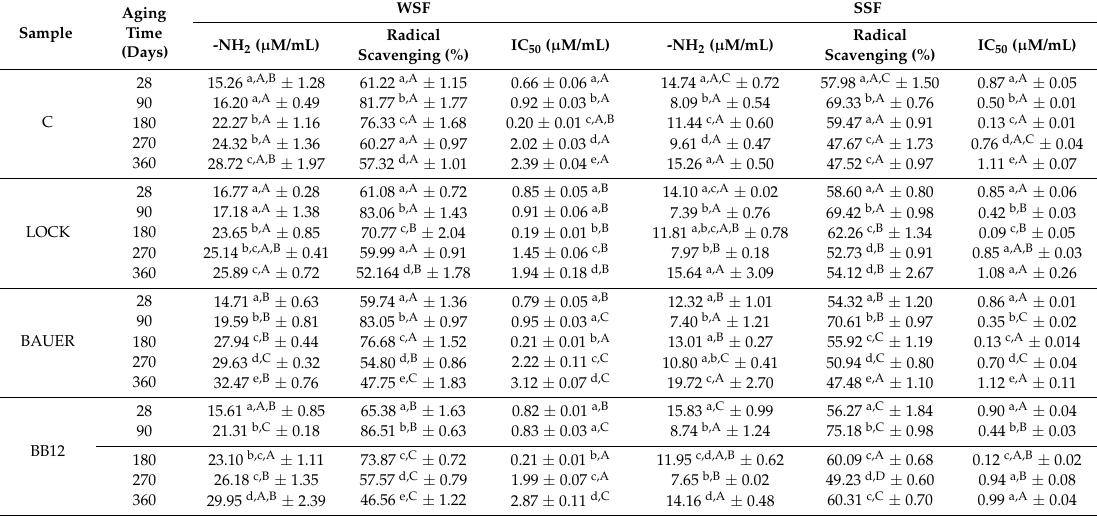
Table 4. Antiradical activity of protein hydrolysates after gastric digestion (mean ± standard deviation).